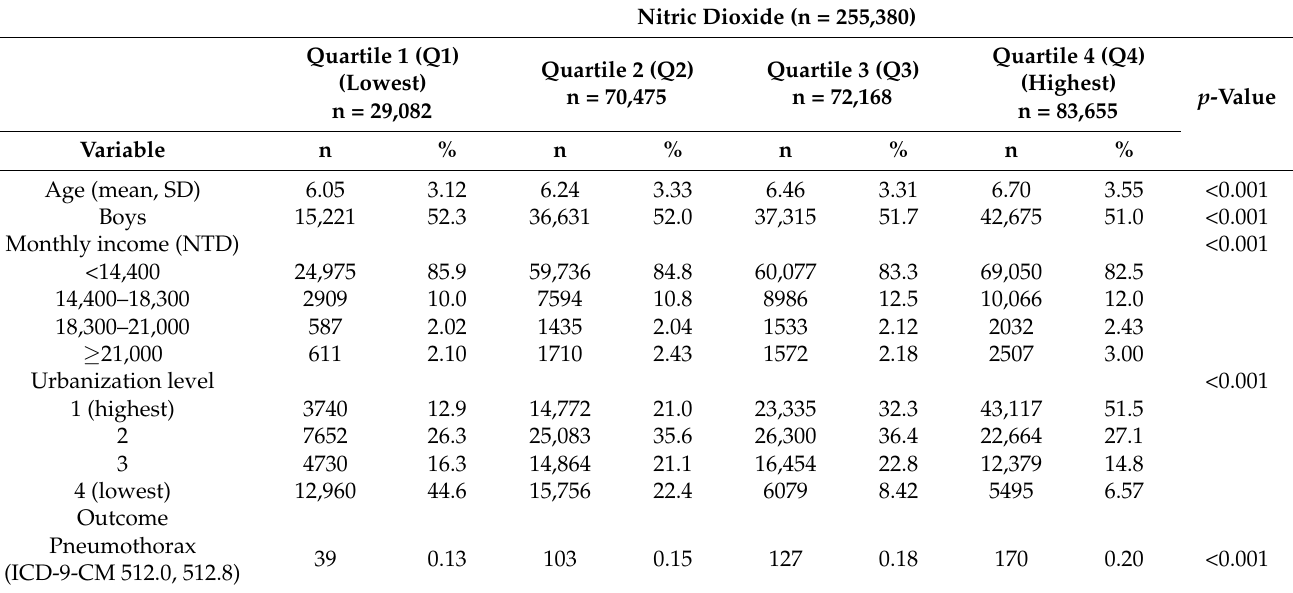
Table 2. Characteristics of participants exposed to various annual average concentrations of nitro- gen